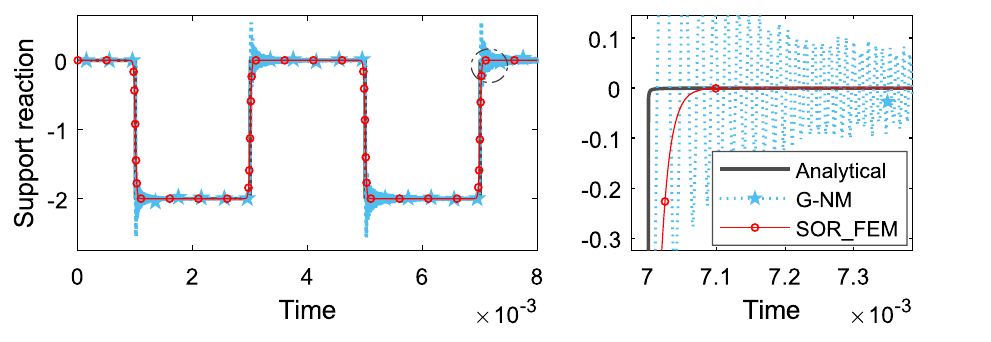
Figure 16. Time history of support